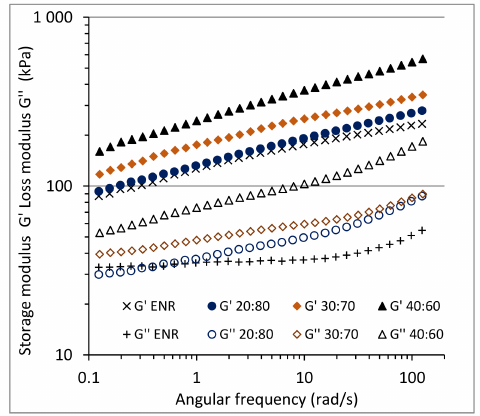
Figure 9. Storage shear modulus G’ and loss shear modulus G’’ as a function of angular frequency at 30 °C for PLA/ENR blends.